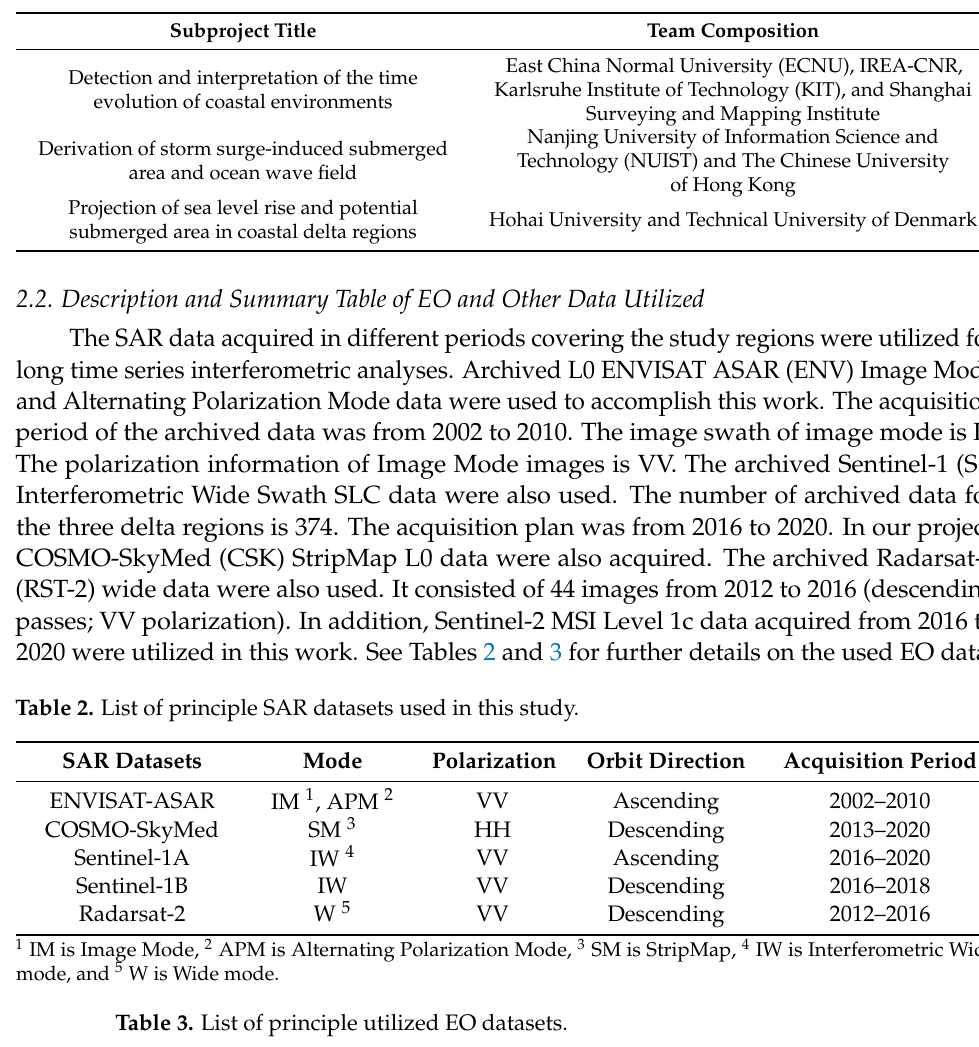
Table 1. Project information.